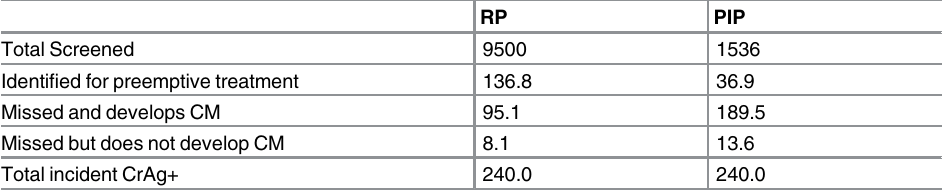
Table 3. Outcomes from screening modules for 100,000 patients screened for cryptococcal antigene- mia (CrAg).